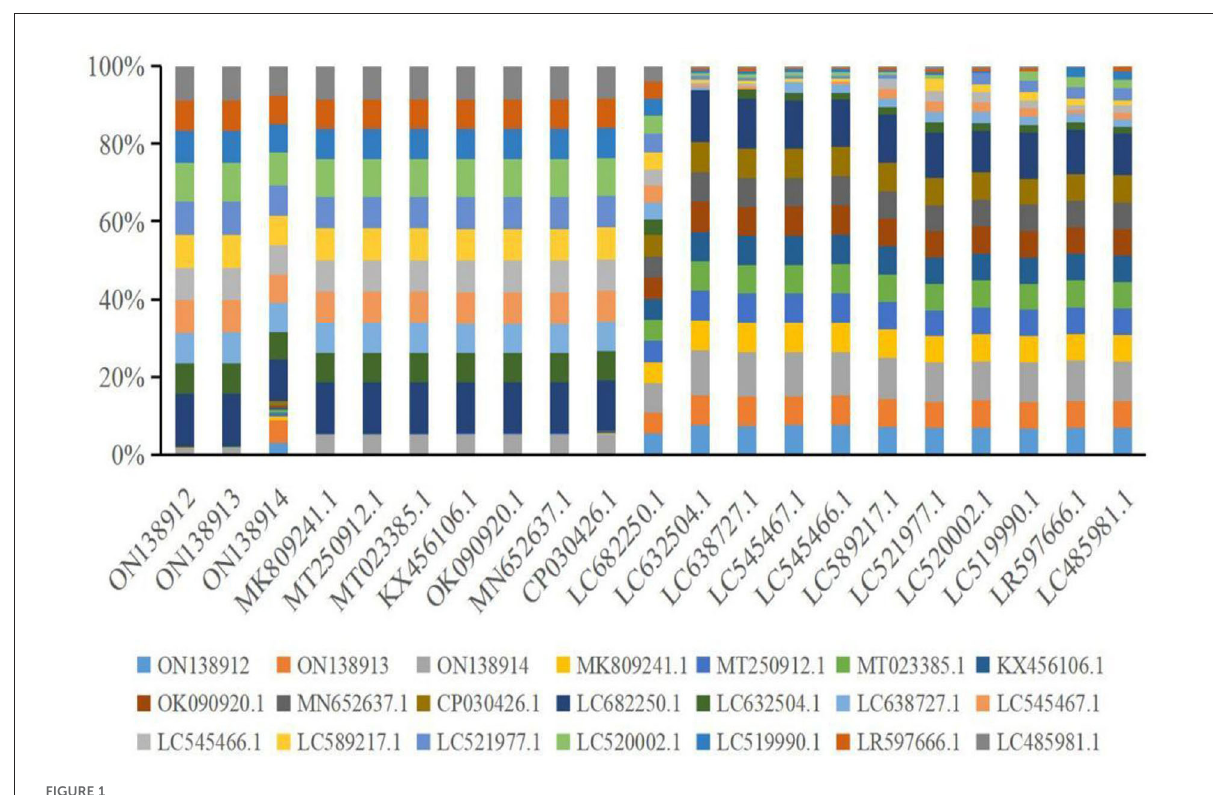
FIGURE1 Multiple alignments analysis of 16s rRNA gene of Staphylococcus aureus (S. aureus) with reference strains.